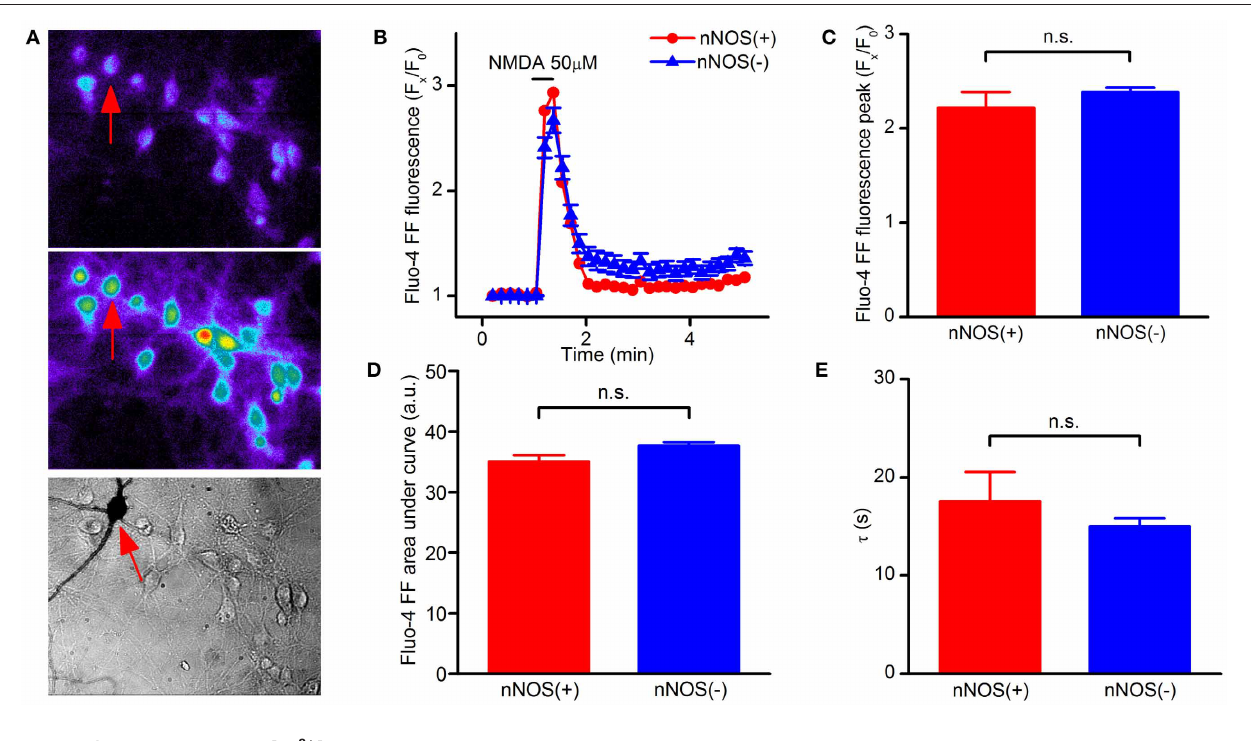
FIGURE 2 | NMDAR-dependent [Ca 2 + ] i rises in striatal cultured neurons evaluated with a low affinity Ca 2 + -sensitive probe. (A) Fluorescence images of fluo4-FF loaded striatal neurons before (top) and upon NMDA exposure (middle). Bright field image (bottom) showing stained nNOS( + ), indicated by arrows, and nNOS( − ) neurons. (B) Time course of NMDAR-dependent[Ca 2 + ] i rises, traces of a single experiment [nNOS( + )